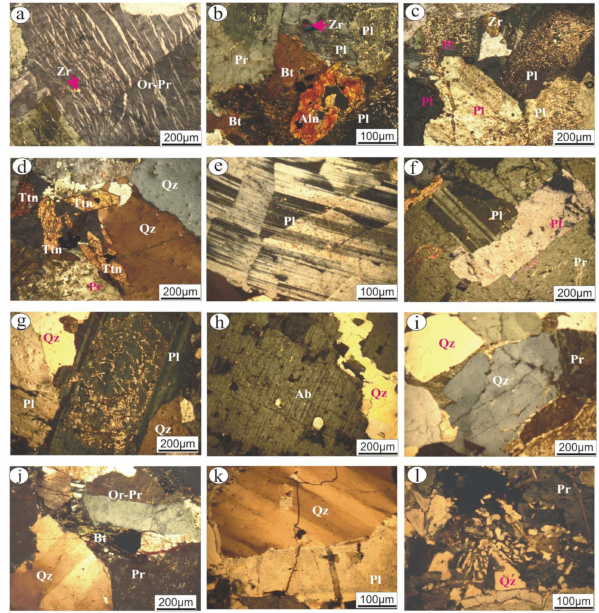
Figure 2. Photomicrographs of the examined commercial granitic rocks showing: Gandonna rock sample: ( a ) Simple twining of flamy orthoclase perthite (Or-Pr) engulfing minute zircon (Zr) crystal; ( b ) Allanite (Aln) (filled by iron oxides) associated with biotite (Bt). Pink granite rock sample: ( c ) Aggregate of turbid plagioclase (Pl) crystals due to extensive saussuritization; ( d ) Euhedraltitanite (Tnt) in association with quartz (Qz). Buff granite rock sample I: ( e ) Slightly saussuritized twisted plagioclase. Buff granite rock sample II: ( f ) Pristine perthite crystal engulfing plagioclase and biotite; ( g ) Extensive saussuritization of plagioclase associated with quartz. Fantazia rock sample: ( h ) Microveinlets of secondary quartz-traversed coarse-grained perthite crystals. Red granite rock sample: ( i ) Reaction rim of albite developed around kaolinitizedperthite; and ( j ) Simple twinning of orthoclase perthite associated with undulose quartz. Qusseir brown rock sample: ( k ) Extended fracture in perfect undulose quartz and Kaolinitized plagioclase filled by secondary quartz; ( l ) Perfect granophyric texture. Table 1. Summary of petrographical investigation of granitic